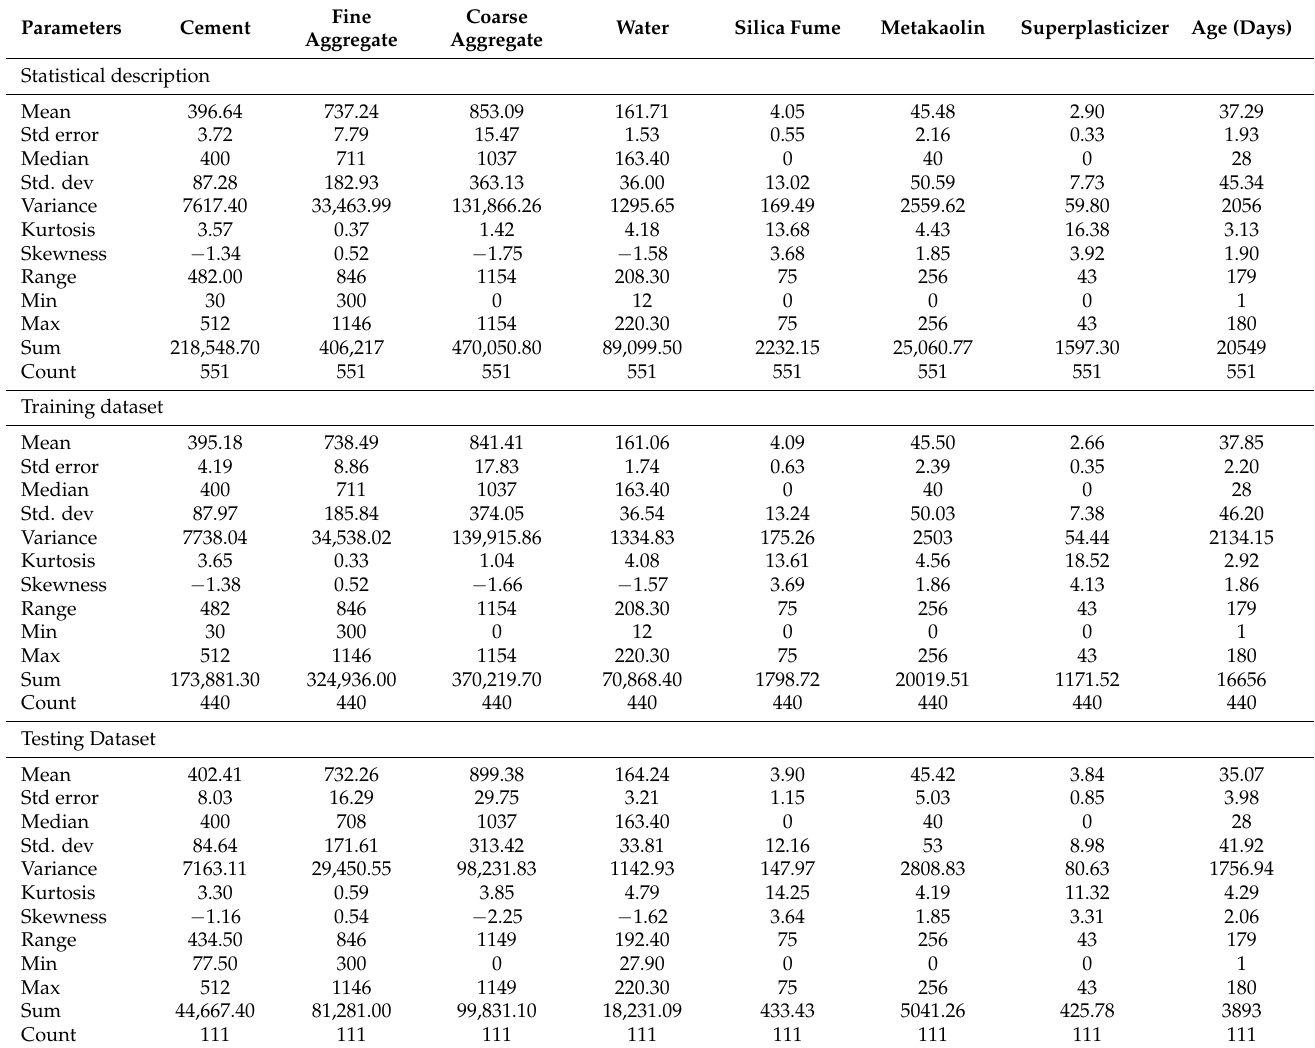
Table 2. Statistical description of Metakaolin concrete